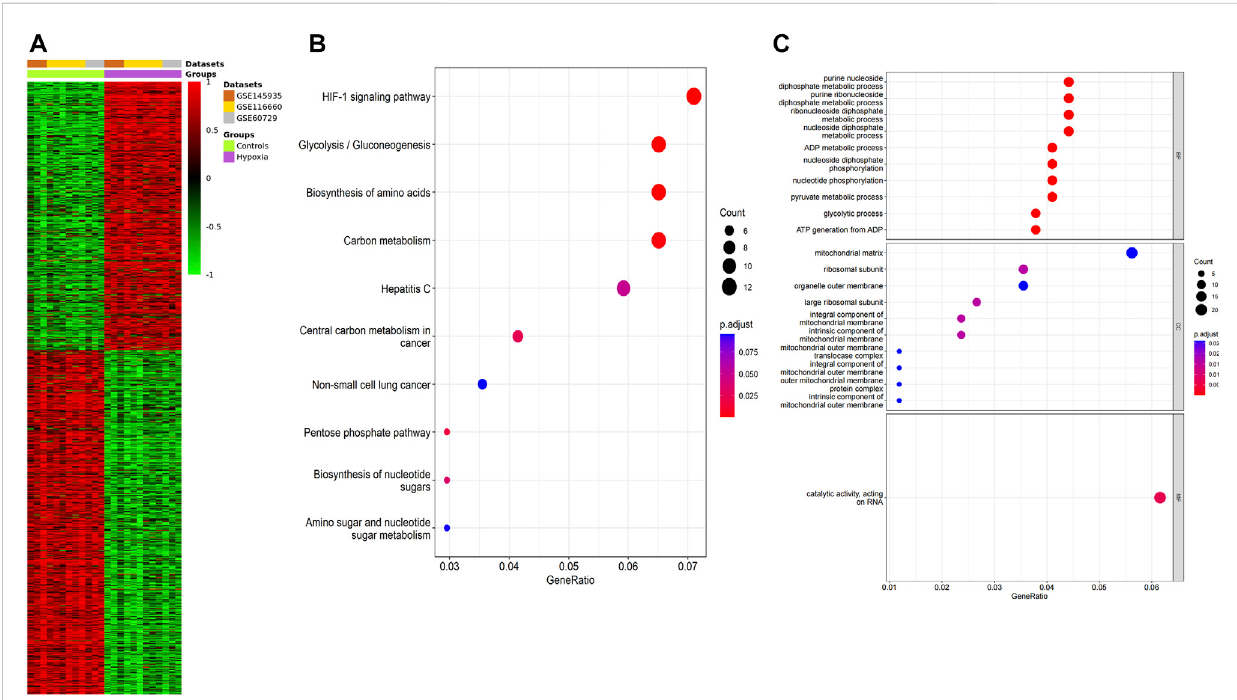
FIGURE 4 Function annotation of meta-analysis results. (A) The heatmap of the DEGs according to the adjusted p -value and logFC. Red indicates higher gene expression, and green shows lower gene expression. (B) KEGG terms in the enrichment analysis of the DEGs. (C) GO terms in the enrichment analysis of the DEGs.